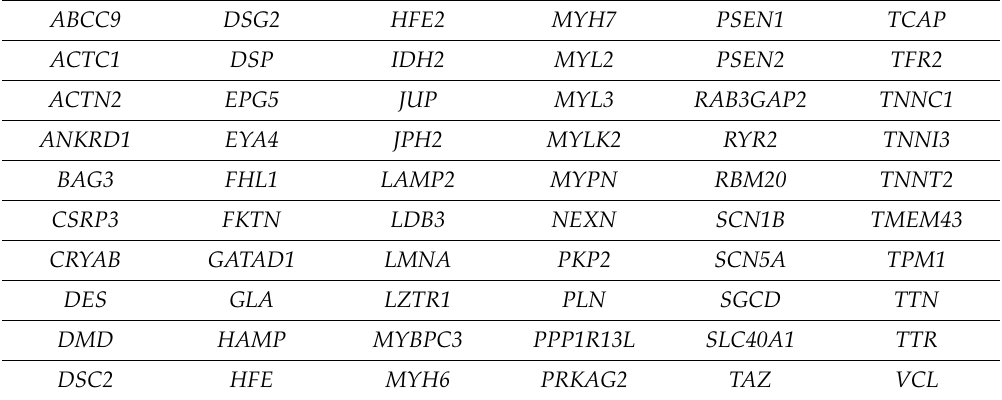
Table 1. Genes associated with cardiomyopathy used in the cardiomyopathy (CM) 60